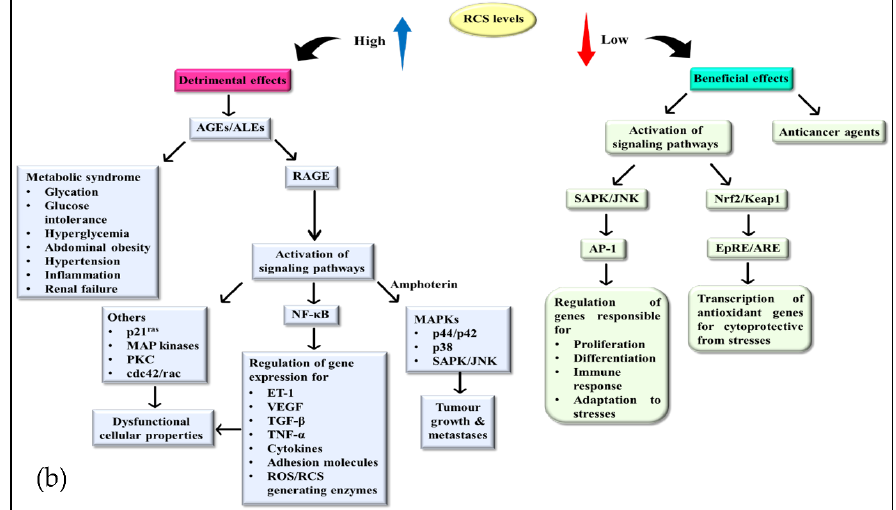
Figure 3. Detrimental and beneficial effects of RCS ( a ); Cytotoxic effects of RCS leading to cellular or tissue dysfunction ( b ) [90,93,94].